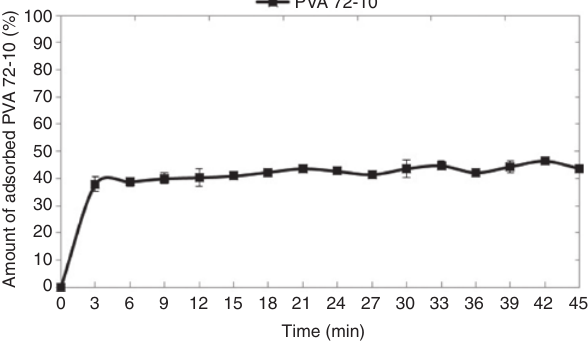
Figure 6: Kinetic trend of PVA 72-10 adsorption on Cloisite ® Na + ( ± standard deviation).